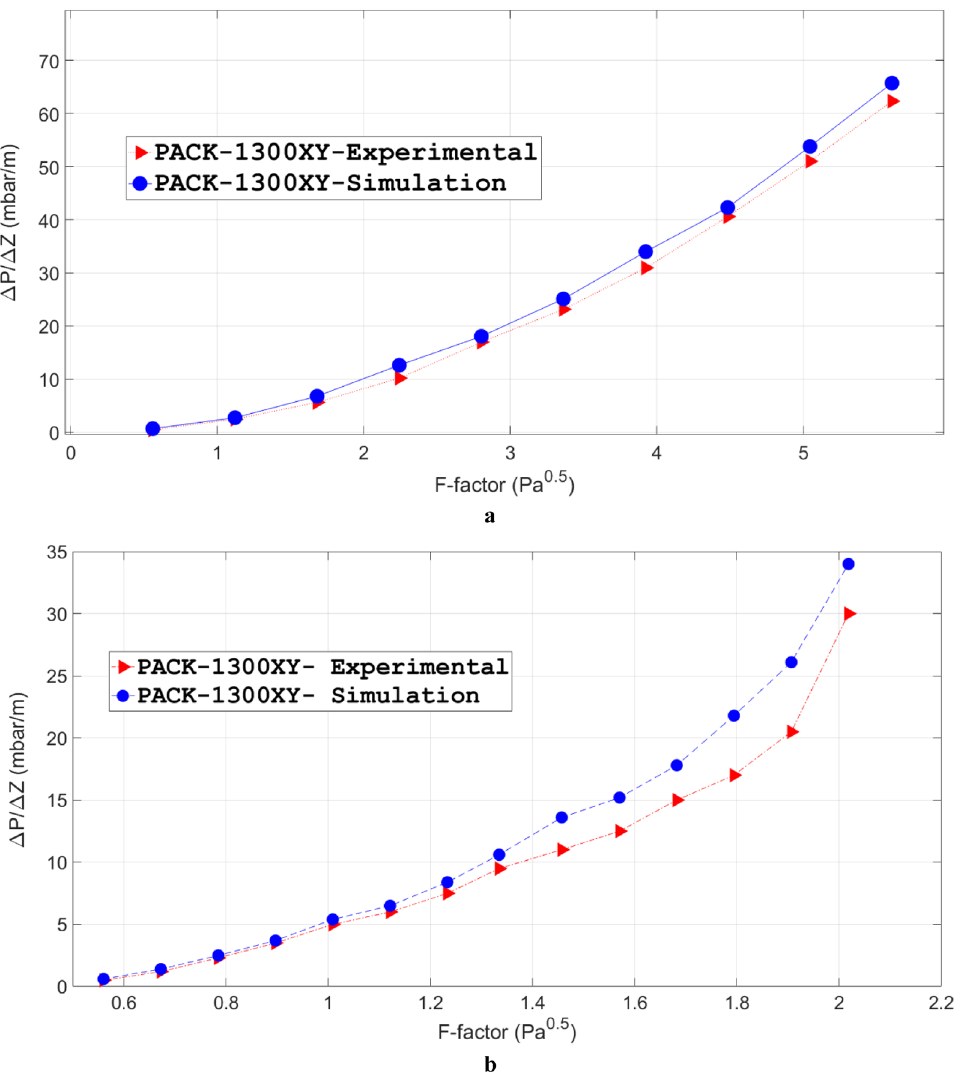
Figure 2. The experimental measurements (red triangle) and simulation results (blue circle) for the dry ( a ) and wet ( b ) pressure drop of the PACK-1300XY as a function of